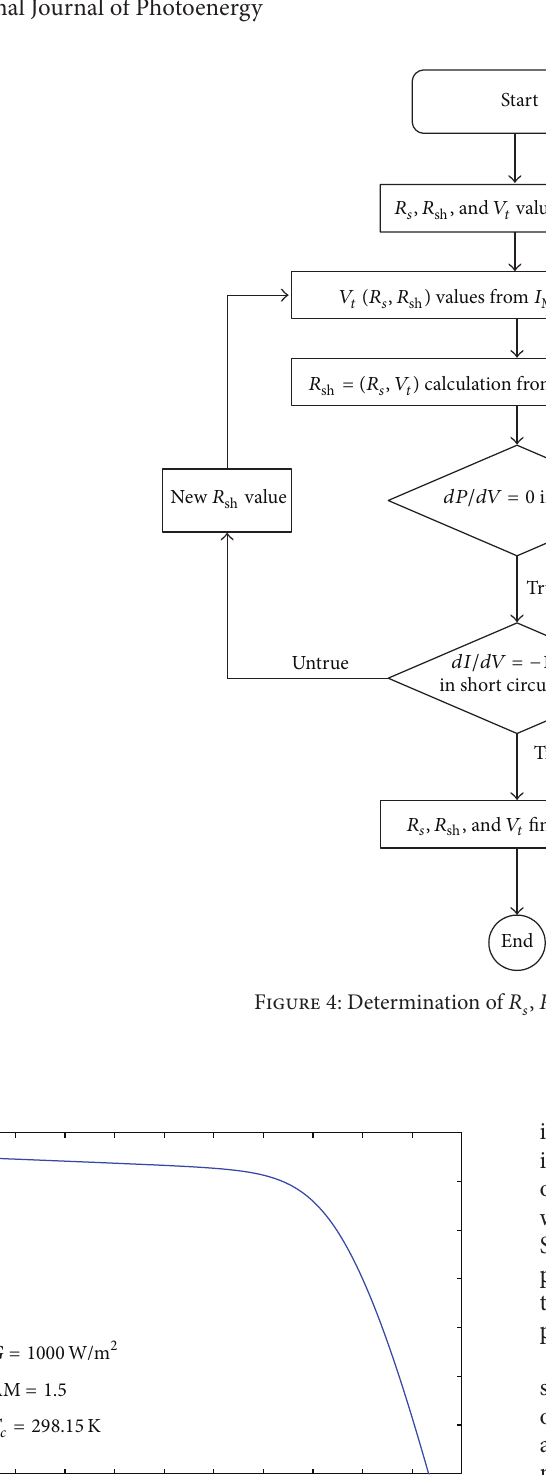
Figure 5: 𝐼 - 𝑉 curve from the five-parameter model of a commercial PV